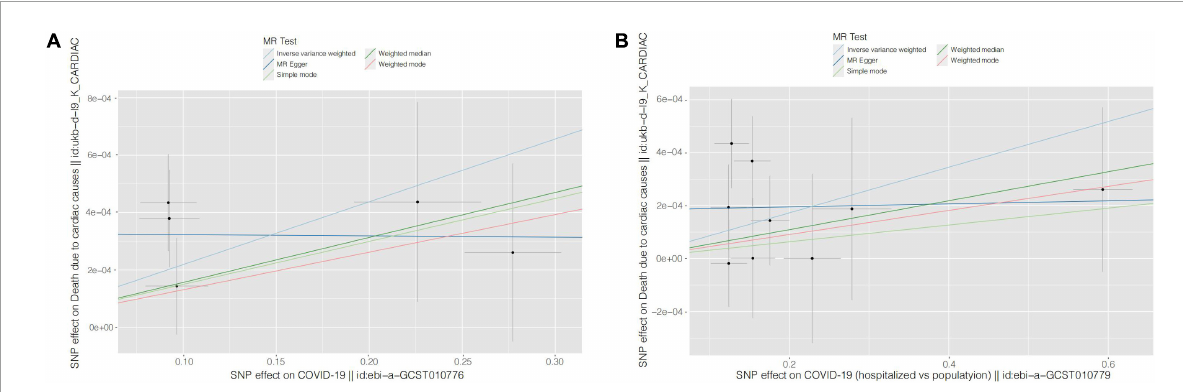
FIGURE2 Scatter plots for causal SNP effect of COVID-19 on CVD death. Each black point representing each SNP on the exposure (horizontal-axis) and on the outcome (vertical-axis) is plotted with error bars corresponding to each standard error (SE). The slope of each line corresponds to the combined estimate using each method of the inverse variance weighted (light blue line), the MR-Egger (blue line), the simple mode (light green line), the weighted median (green line), and the weighted mode (pink line). (A) COVID-19 susceptibility; (B) COVID-19 hospitalization.